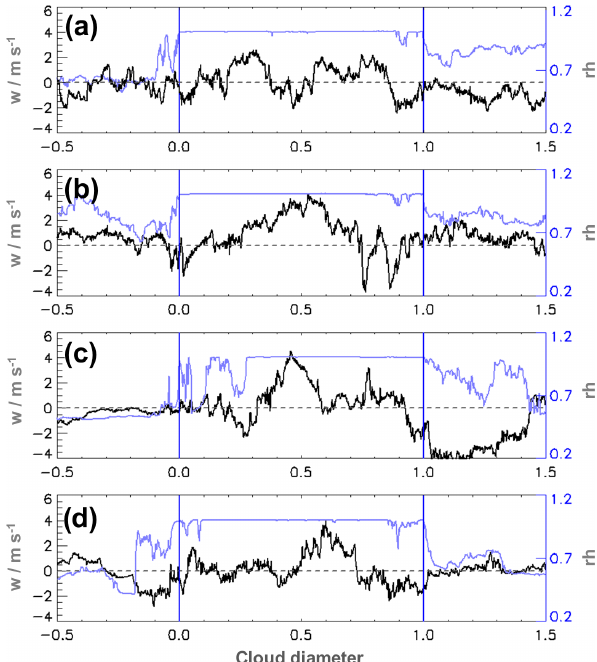
Figure 5. Measurement values for a crosswind transect through an active cloud during flight 2 looking downwind. The cloud bound- aries are marked by the blue vertical lines. Panel (a) shows relative humidity; (b) vertical wind; (c) buoyancy without the contribution of LWC and (d) the horizontal pressure perturbation.